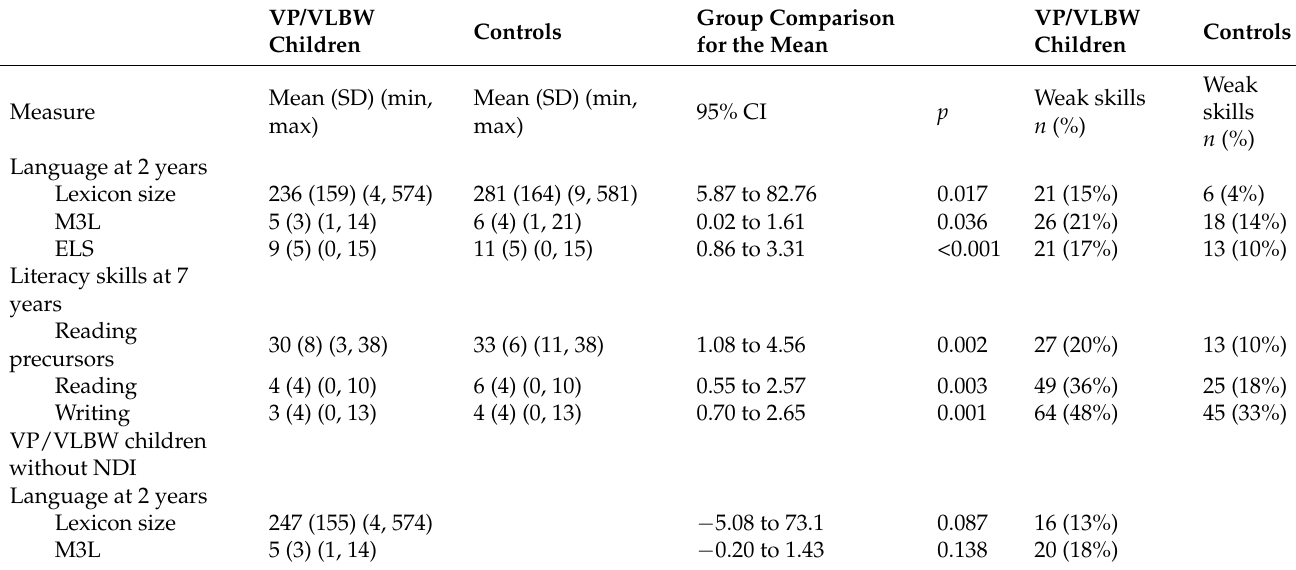
Table 2. Descriptive statistics and group comparisons for the language variables at 2 years of age and literacy variables at 7 years of age for all VP/VLBW children, for VP/VLBW children without neurodevelopmental impairment (NDI), and for full-term